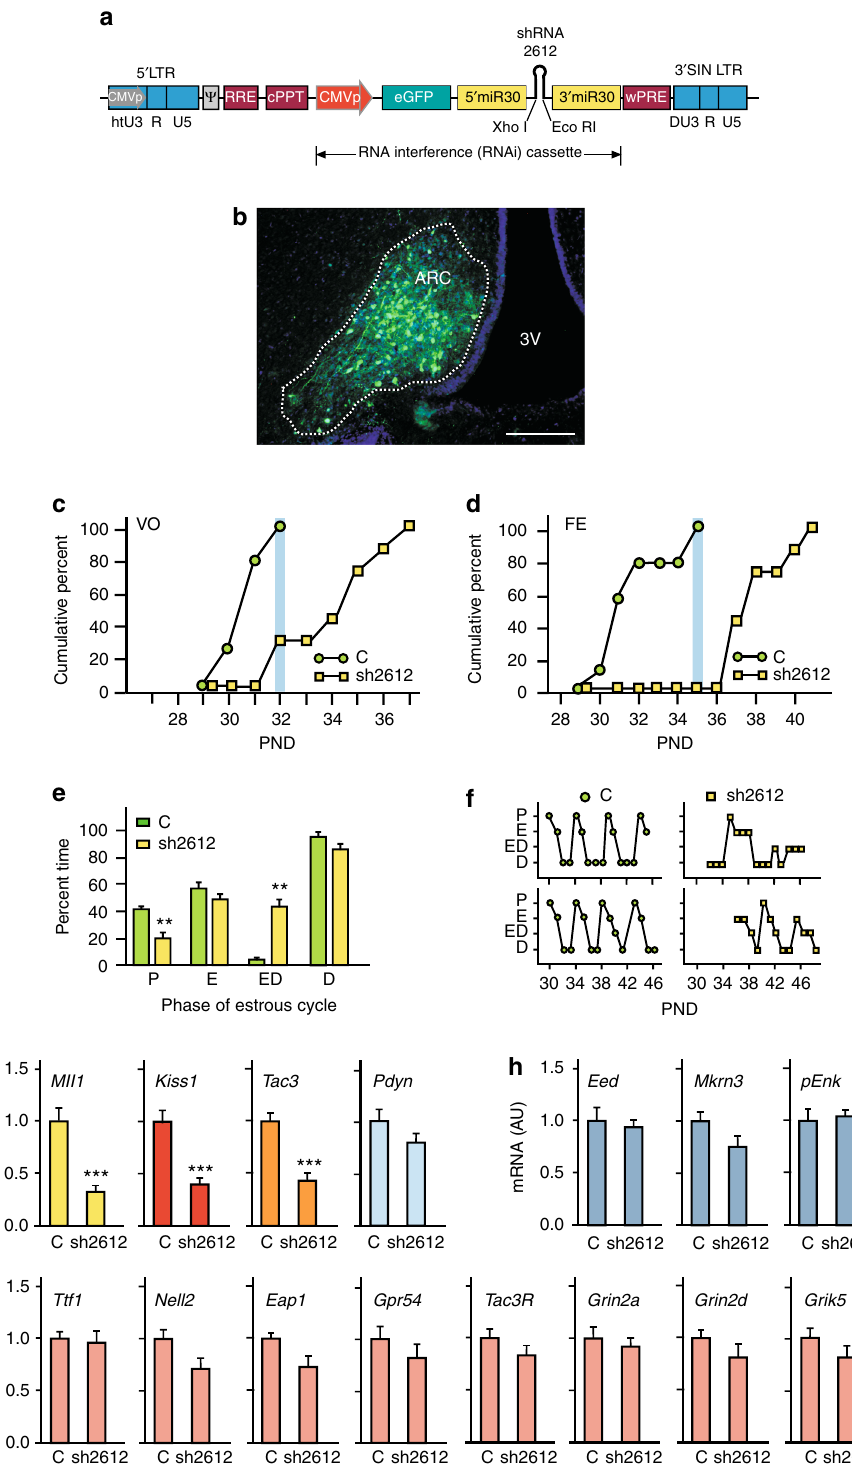
Fig. 5 Silencing the Mll1 gene in the ARC of immature female rats. a Lentiviral construct (LV-shMll1-GFP) encoding sh2612 that most effectively silences Mll1 . b Transduction of ARC cells with sh2612 delivered to the ARC of EJ female rats. Green: sh2612 infected cells; blue: Hoechst-stained cell nuclei in the MBH; dotted line: ARC. Bars, 200 µ m. c Cumulative percent day at vaginal opening (VO), and d cumulative percent day at fi rst estrus (FE) in control (C; n = 9) and sh2612 ( n = 7)-injected rats. Blue shade depicts the time when all C animals show VO or FE. e Percent of time spent in different stages of the estrous cycle by rats injected with C ( n = 9) or sh2612 ( n = 7). f Examples of estrous cycle patterns in rats injected with C or sh2612. g Mll1 , Kiss1 , Tac3 , and Pdyn mRNA levels detected by qPCR in the ARC of LJ female rats receiving C ( n = 8) or sh2612 ( n = 8). h Expression of puberty-inhibitory or i puberty-activating genes in the ARC of LJ female rats receiving C ( n = 8) or sh2612 ( n = 8). RNA expression data were normalized by using peptidylprolyl isomerase A as the housekeeping gene and dividing each individual value by the average of the C group. P = proestrous; E = estrous; ED = transitional phase (estrous/ diestrous); D = diestrous; AU = arbitrary units; 3V = third ventricle. Bars represent mean ± s.e.m. (** P < 0.01, *** P < 0.001 vs. C, Student ’ s t